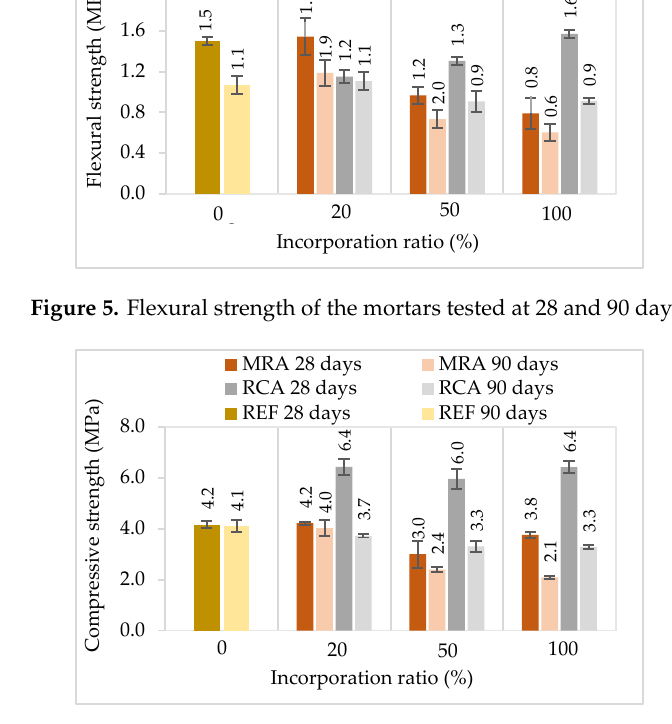
Figure 6. Compressive strength of the mortars tested at 28 and 90 days.